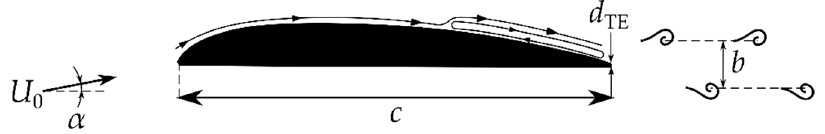
Figure 1. Profile vortex shedding (PVS).